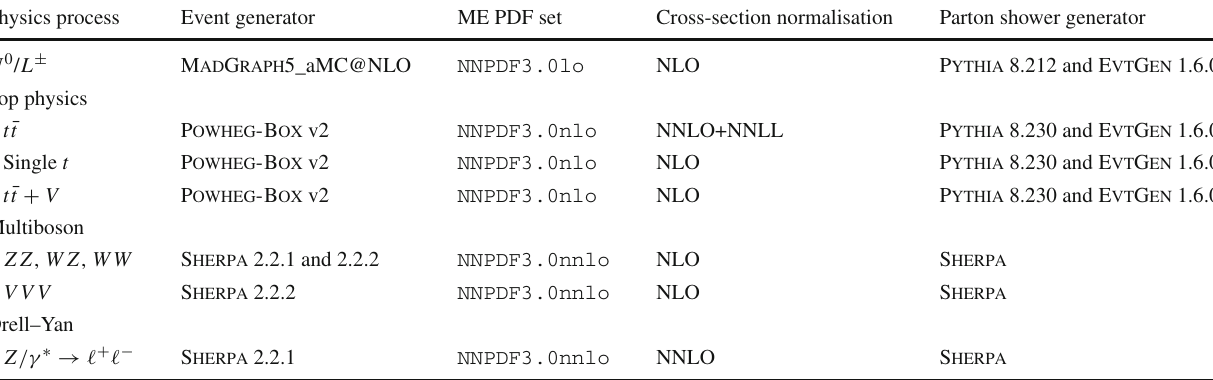
Table 1 The event generator, parton shower generator, cross-section normalisation, and PDF set used for the matrix element (ME) calculation are shown for each simulated signal and background event sample. The generator cross-section is used where not specifically stated otherwise